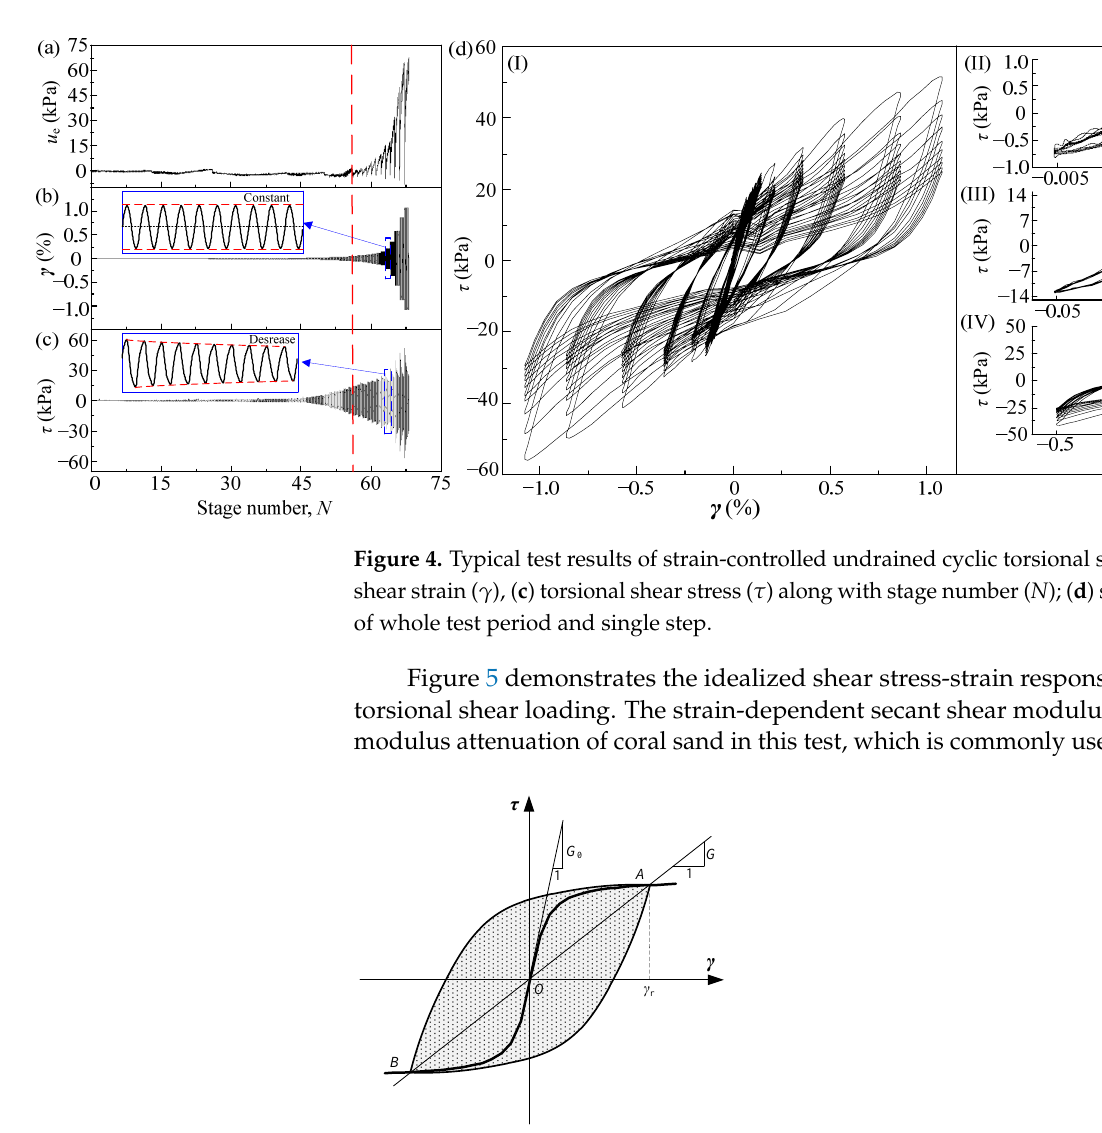
Figure 5. The idealized shear stress-strain response of soil under cyclic loading.